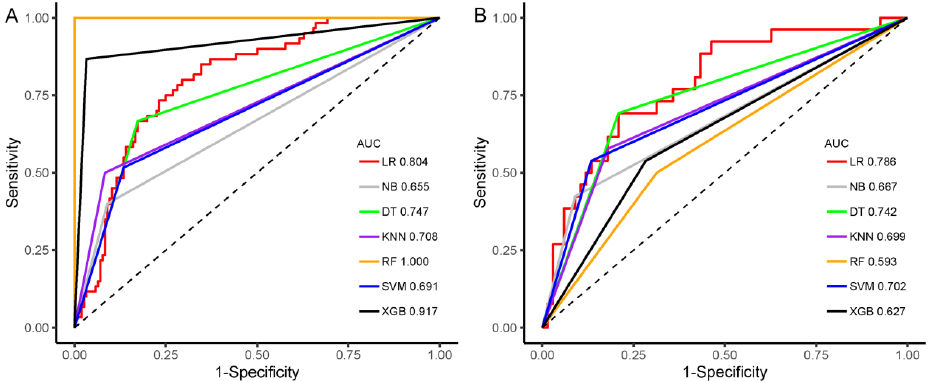
Figure 7. Receiver operating characteristic curves of seven machine learning classifiers predicting HER2+ status in training ( A ) and validation sets ( B ). Table 5. P values for AUC comparison between any pair of models tested by the DeLong method in the validation set.